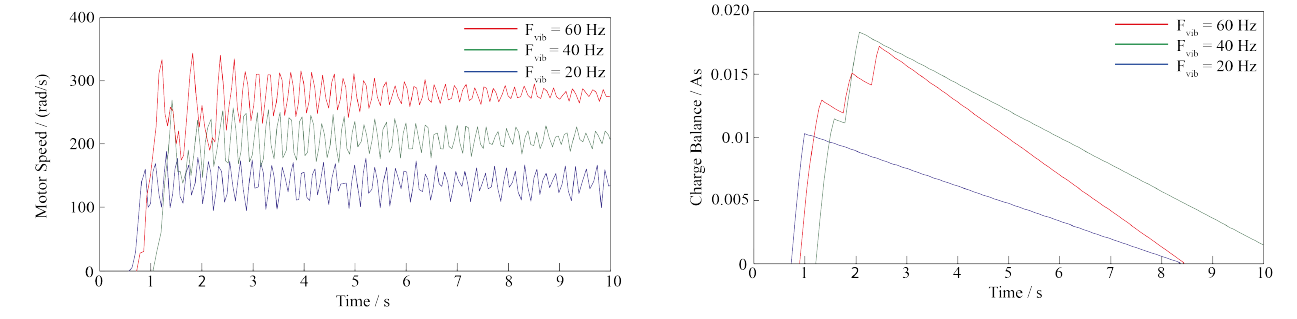
Figure 14. Setup of the measuerement equipment. Figure 15. Measured motor speed with respect to frequency and Figure 15. Measured motor speed with respect to frequency and time.